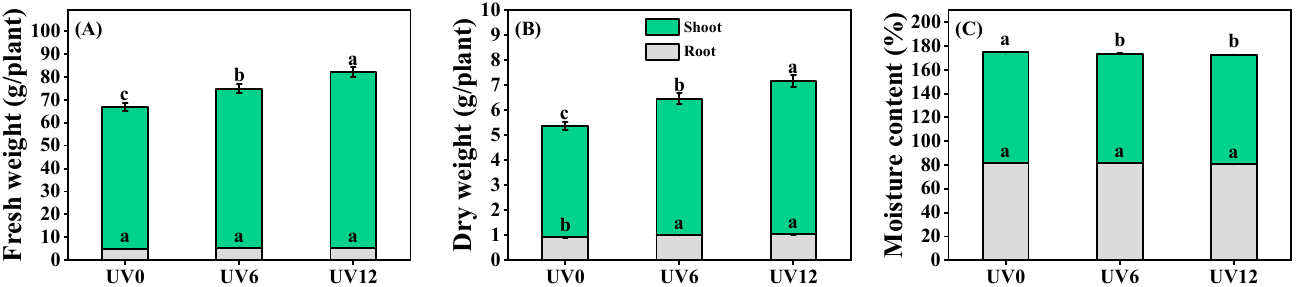
Figure 1. Growth properties of Chinese kale exposed to UVA-radiation exposure of different durations. ( A ) Fresh weights of shoots and roots (S-FW and R-FW). ( B ) Dry weights of shoots and roots (S-DW and R-DW). ( C ) Moisture contents of shoots and roots (S-MC and R-MC). Different lowercase letters (a–c) labeled on the vertical bar (means ± standard error, n = 8) represent significant differences by one-way ANOVA with multiple-range tests ( p ≤ 0.05).